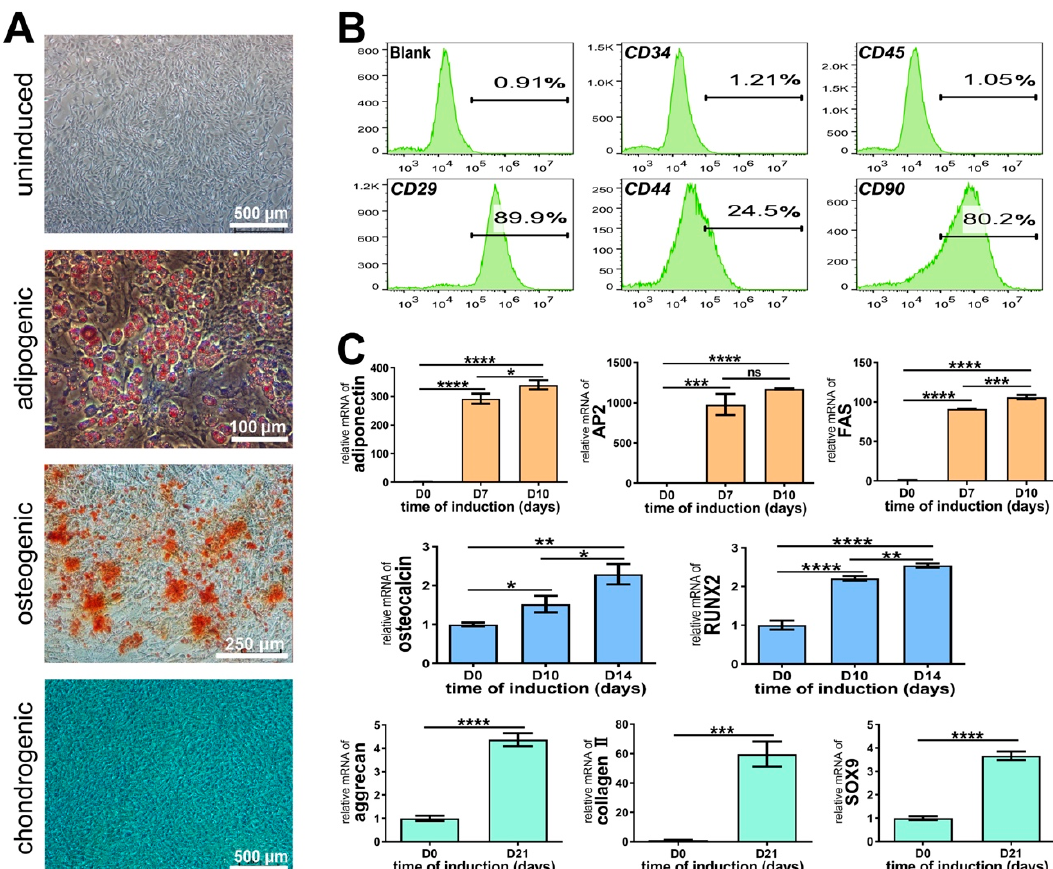
Figure 3. Identification of rat CSPCs. ( A ) Multilineage differentiation of the isolated CSPCs. On the 7th day of adipocytic differentiation, lipid-rich vacuoles stained with Oil red O are observed within the cytoplasm. On the 10th day of osteogenic differentiation, calcium nodules that are positive for Alizarin Red are formed. On the 21st day of chondrogenic differentiation, the CSPCs are all positive for Alcian blue. ( B ) Flow cytometry analysis of the expression of cell-surface markers. The surface markers that are specifically positive for mesenchyme cells (CD29, CD44, and CD90) are all highly expressed, whereas CD34 and CD45 are negatively expressed. ( C ) The RT-PCR results show a significant increase in mRNA expression of adipogenic markers (adiponectin, AP2, and FAS), osteogenic markers (osteocalcin and RUNX2), and chondrogenic markers (aggrecan, collagen II, and SOX-9) after multilineage-induced differentiation (* p < 0.05, ** p < 0.01, *** p < 0.001, **** p < 0.0001, ns p > 0.05).